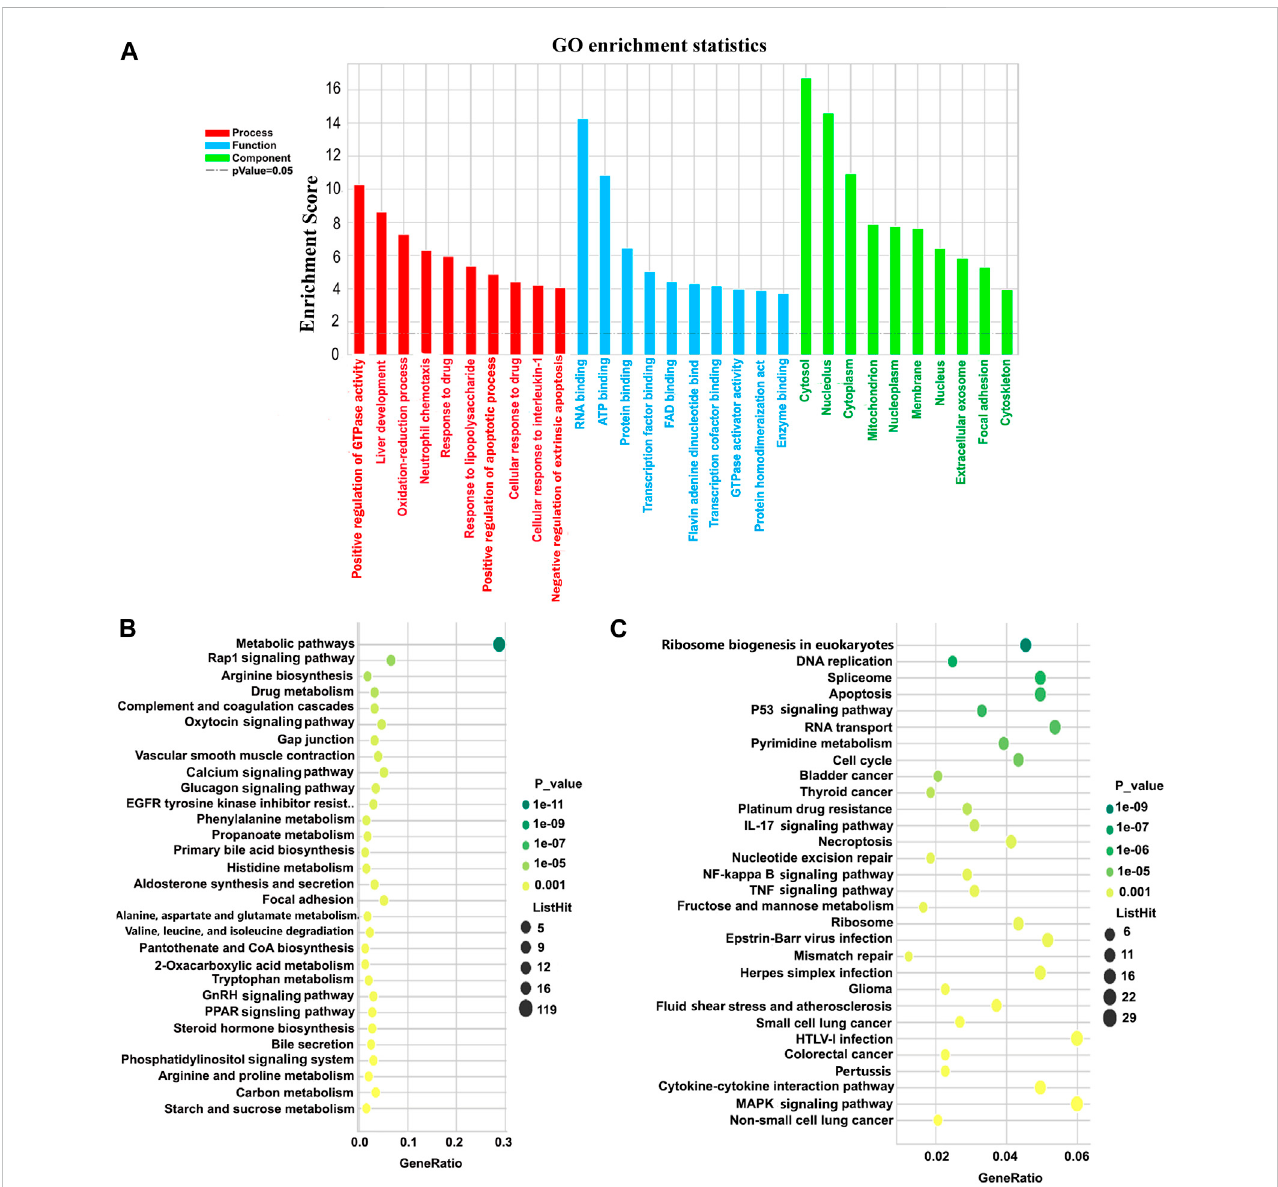
FIGURE 5 GO and KEGG pathway analyses of the biological functions of mRNAs co-expressed with differentially expressed lncRNAs. (A) GO enrichment for all differentially expressed mRNAs. The Y -axis represents -log10 ( p -value), with higher bars therefore representing smaller corresponding p -values. Colors differentiateBPs, CCs, and MFs. (B,C) KEGGbubble chartsfor thetop 30 pathways associated with downregulated and upregulated mRNAs, respectively. The X -axis represents degree of enrichment, and the Y -axis represents the path of enrichment. The larger the bubble, the more genes fell into this pathway, and the greener the color, the greater the signi fi cance of the enrichment. GO, Gene Ontology; KEGG, Kyoto Encyclopedia of Genes and Genomes; BP, biological process; CC, cellular component; MF, molecular